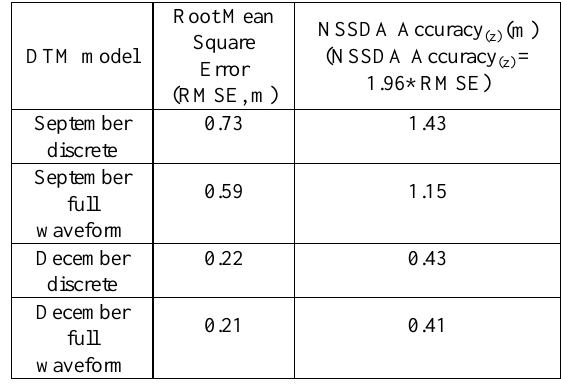
Table 1. Accuracy evaluation of LiDAR derived terrain data